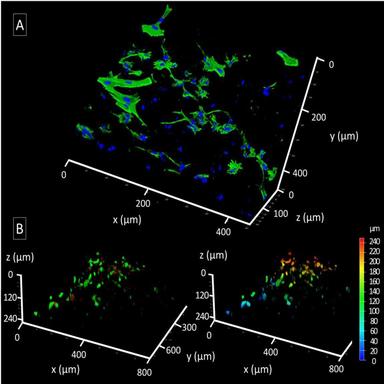
Confocal images of the staining of a cross-section of the bioprinted ZS-EI-ELR bioink loaded with HFF-1 cell. A) actin fibers (green) and cell nucleus (blue), B) live cells (green) and dead cells (red) places distributed within the scaffold. A depth colour coding is included.